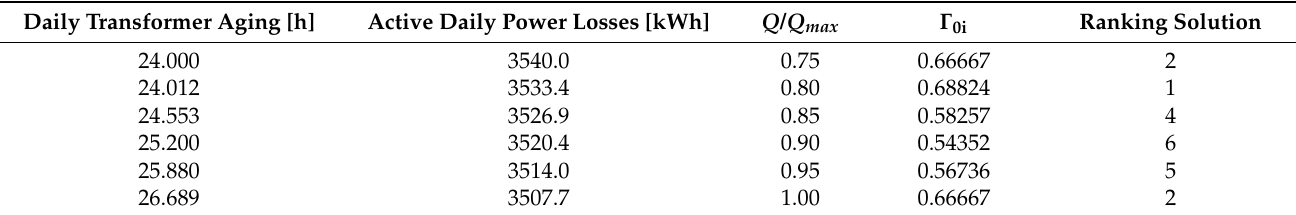
Table 8. Obtained Γ 0i for the set of optimal